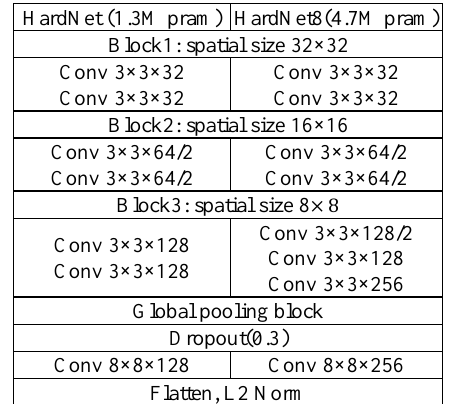
pair. The coarse-to-fine approach of extracting features at 1/8